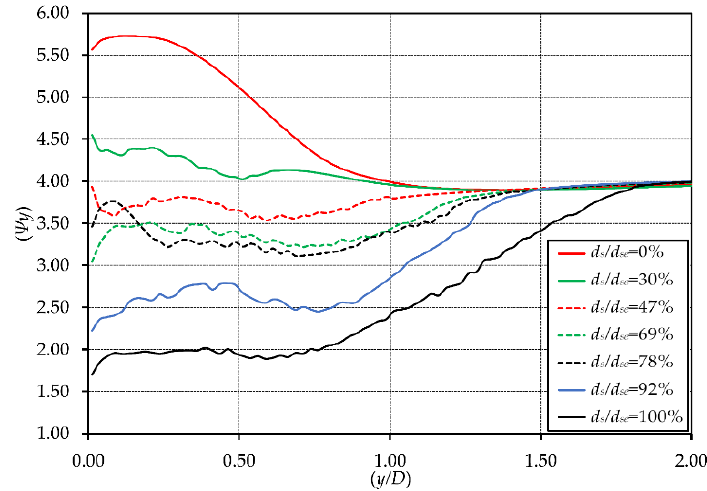
Figure 16. Variation of area-averaged dimensionless circulation (𝛹 𝑦 ) during the scouring stages.